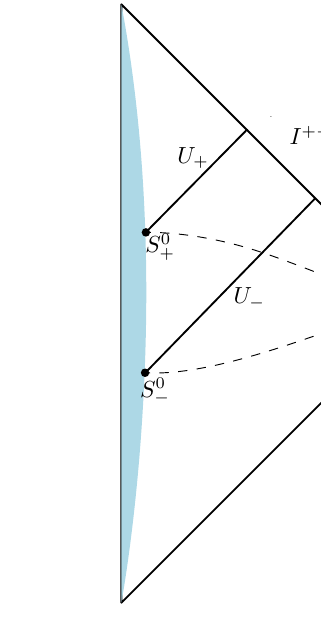
Figure 1 . (Left) Two constant time slices (cid:6) (cid:6) both asymptote to the sphere S 1 at spatial in(cid:12)nity. The coloured region r (cid:20) a , where a is the size of the source, is not described by the linear solution and contains the source. The inner boundaries are denoted as S 0 . (Right) One can smoothly (cid:6) deform (cid:6) (cid:6) such that the di(cid:11)erence of Q rad between the two advanced times u + and u (cid:0) represents I + (cid:0) the multipole moment (cid:13)ux through null